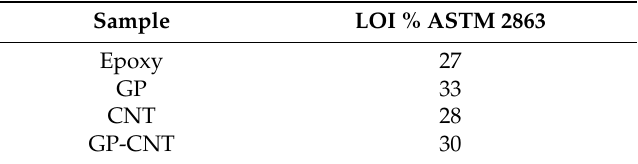
Table 3. Limiting oxygen index (LOI) for filled and unfilled epoxy